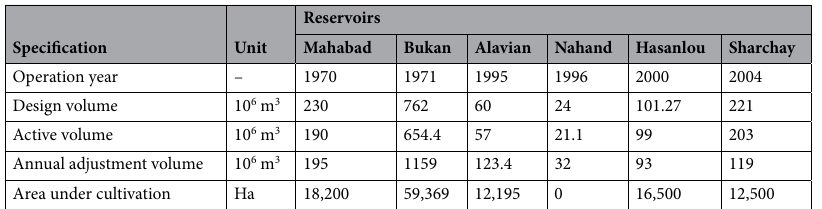
Table 1. Characteristics of operational dams/reservoirs in the Urmia Lake basin (adopted from 23 ).